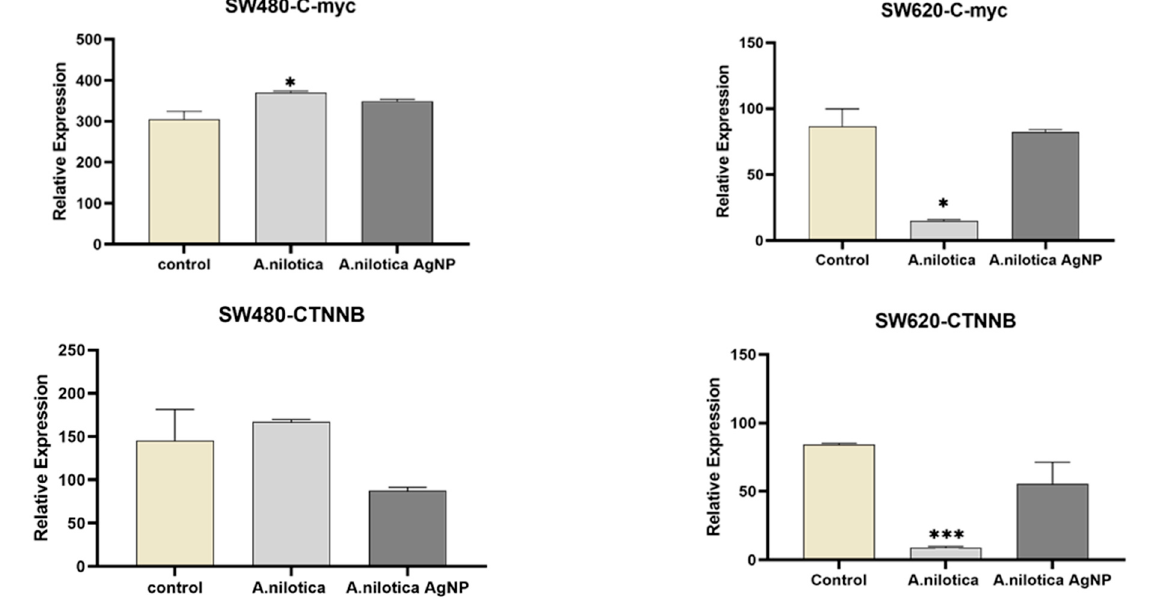
Figure 9. Gene-expression levels in colon cancer cell lines (SW480 andSW620) treated with A. nilotica pod extract and AgNPs; control (without treatment) versus treated cell line. * p ≤ 0.05; ** p ≤ 0.01; *** p ≤ 0.001.